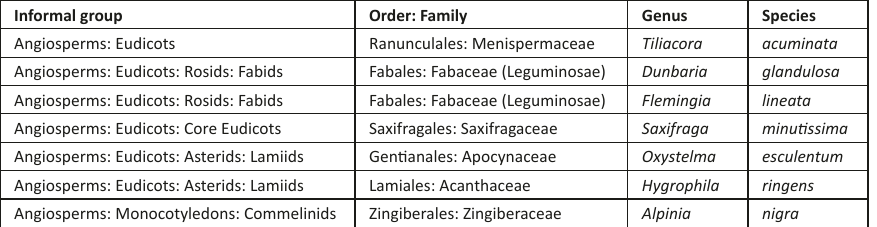
Image 12. Alpinia nigra (Gaertn.) Burtt